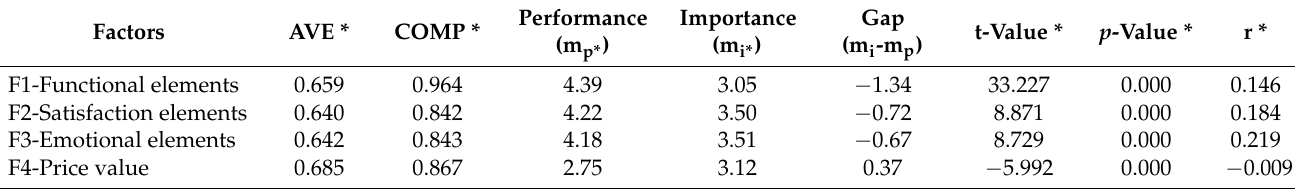
Table 3. Comparative factor importance–performance analysis of